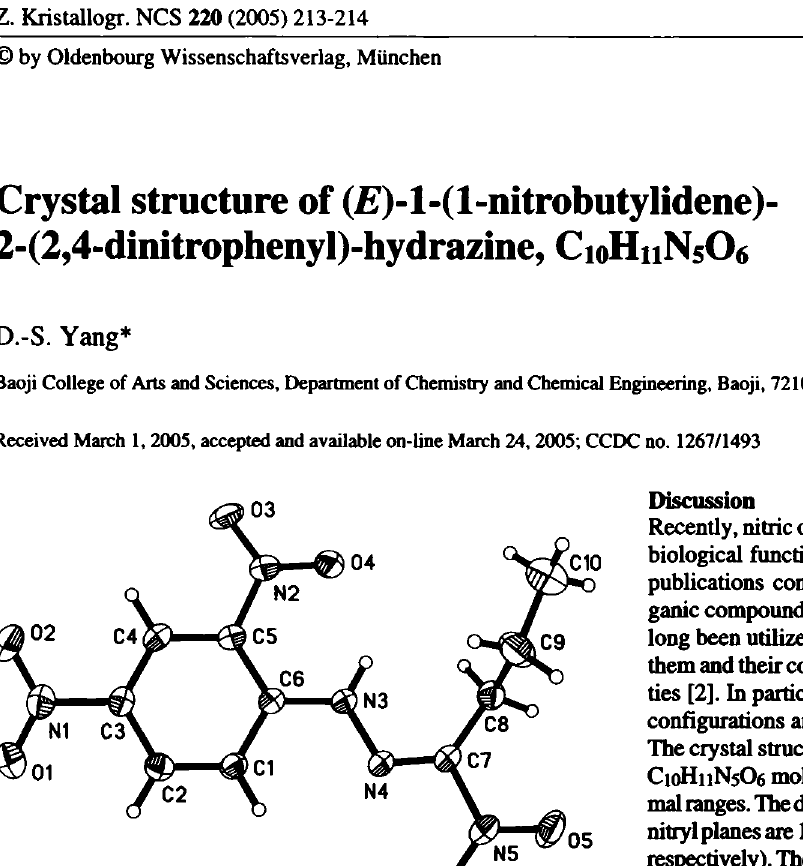
Table 1. Data collection and handling. Crystal: Wavelength: